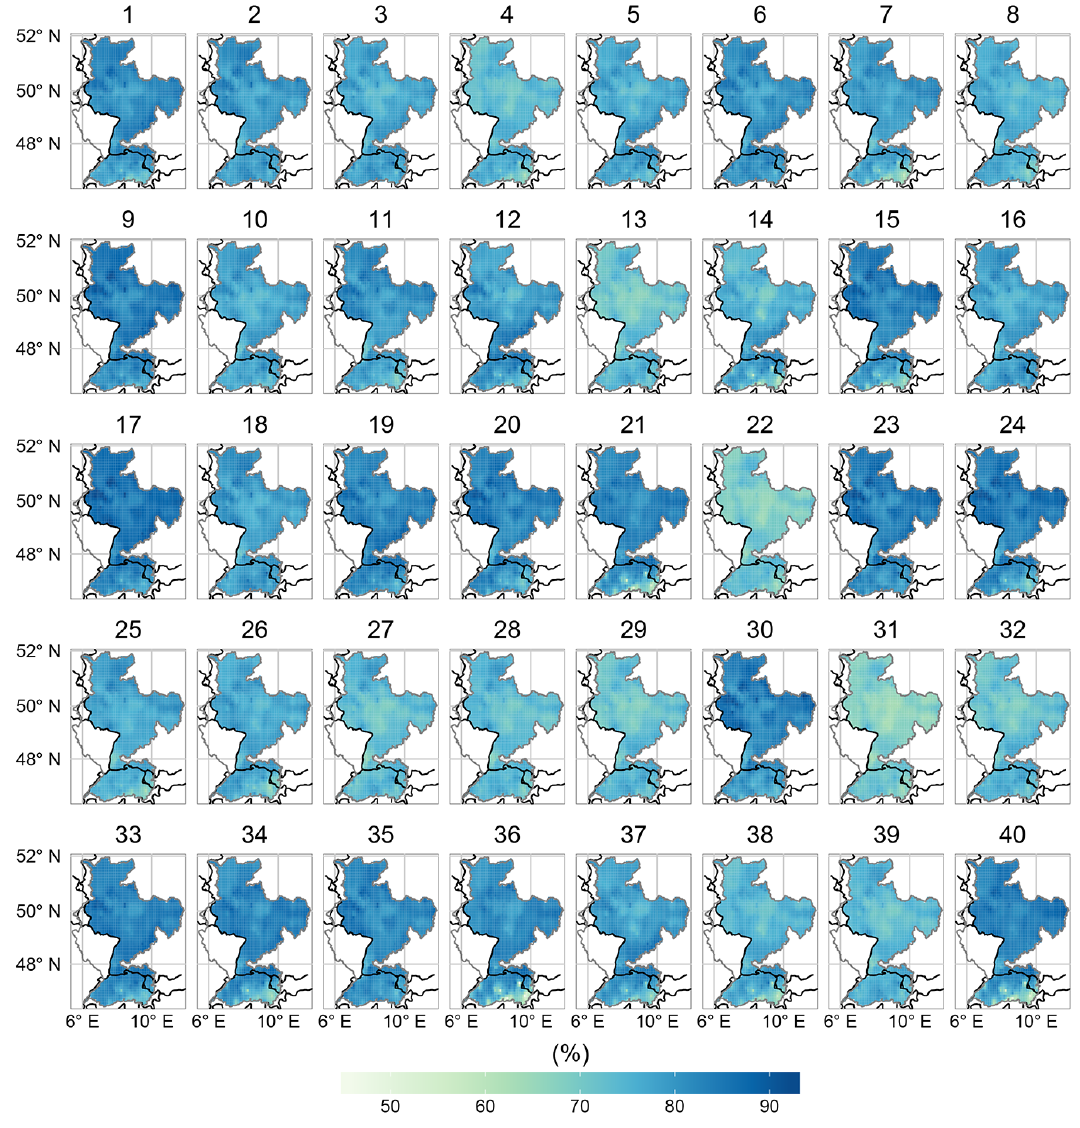
Figure A4. As in Fig. A1 but for relative